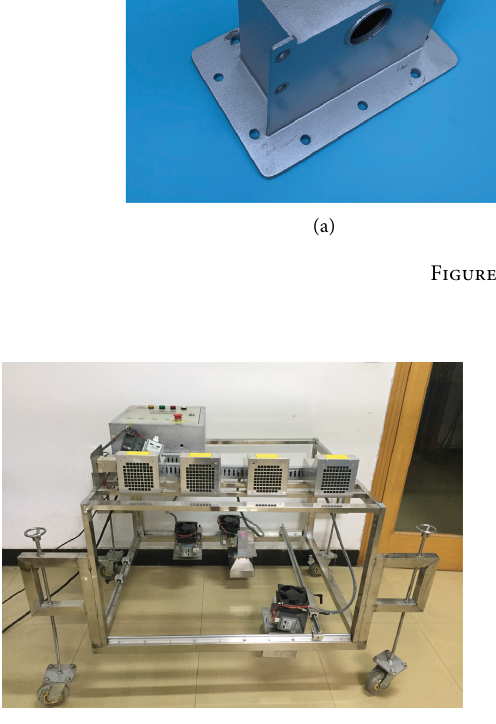
Figure 5: Open adjustable height multi-wavelength source mi- crowave deicing vehicle.